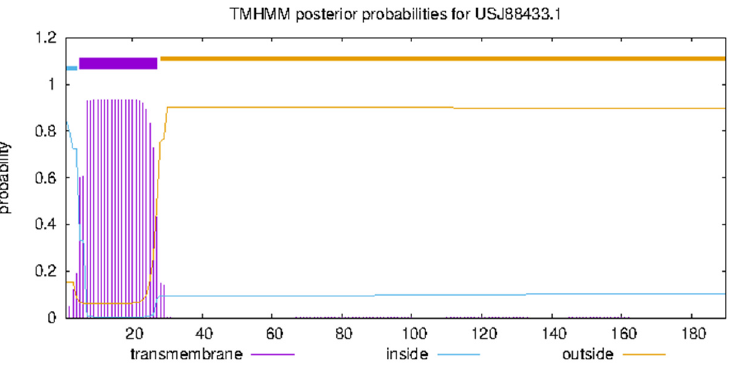
Figure 1. Transmembrane helices prediction in MPXVgp181 protein by TMHMM.